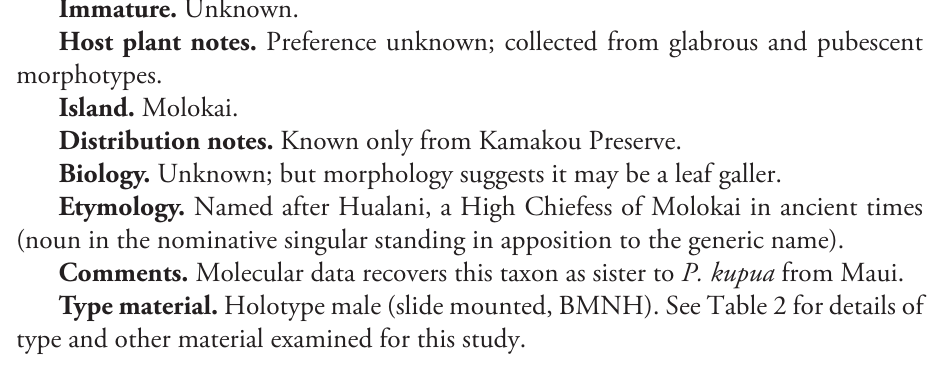
Adult colour. General body colour yellow-brown to green. Females often appear to have a dark abdomen due to darkly pigmented egg load. Fore wing membrane clear, or slightly fuscous. Adult structure. Fore wing apex rounded; spinules distributed in all cells; short se- tae on margins and veins (Fig. 38A–B). Antennae long (av. length 1.35; ratio AL:HW av. 2.08); genal processes extremely long, longer than or subequal to vertex length (ratio VL:GP av. 0.93), and acute; long to medium-long setae on vertex and thorax; distal proboscis seg- ment short (av. length 0.10); hind tibia length subequal to head width (ratio HW:HT av. 1.01) (Fig. 38C–H). Male terminalia (Fig. 38I–L): paramere longer than proctiger (ratio MP:PL av. 0.9), broad at the base, and medially expanded before tapering evenly to apex with anteriorly directed hook; distal aedeagus segment shorter than paramere (ratio PL:AEL av. 1.25) with base rounded, not or slightly inflated, and a shallow hooked apex (ratio AEL:AELH av. 2.07). Female terminalia (Fig. 38M–P): proctiger short, dorsal surface more or less straight to convex apically, apex bluntly acute to acute, anal ring short (ratio FP:RL av. 4.65); subgenital plate with slight or no medial bulge ventrally, bluntly acute to acute api- cally; ovipositor apex lacking serrations, valvulae dorsalis not or moderately convex dorsally. Egg. Short, broad, pigmented brown to dark brown (except tip of pedicel and tail), surface with coarse microsculpturing, and either with distinct medium-long pedi- cel with slightly inflated tip, or pedicel obscured and an unsclerotized patch at the base of the egg, tail medium-short (Fig.